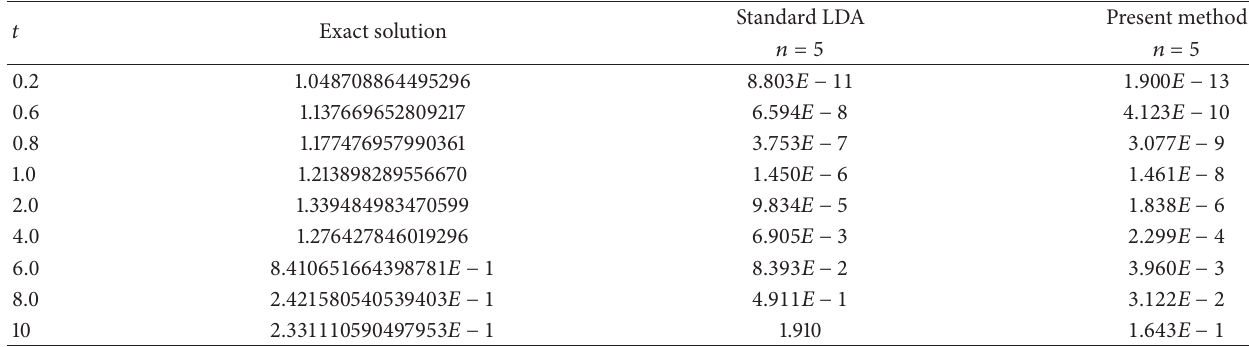
Table 1: Comparison of the absolute errors for Example 1.